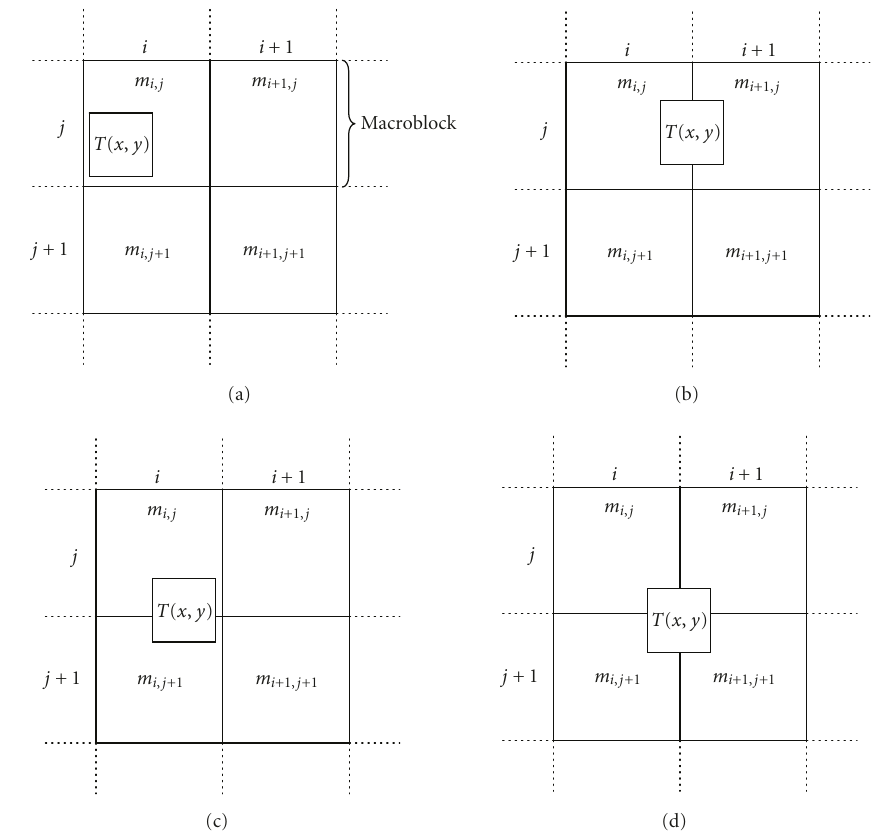
Figure 4: Mapping of the ROI mask element T ( x , y ) onto the macroblock m i , j . (a) The ROI mask element fits completely in the macroblock m i , j . (b), (c), and (d) the ROI mask element overlaps with neighboring